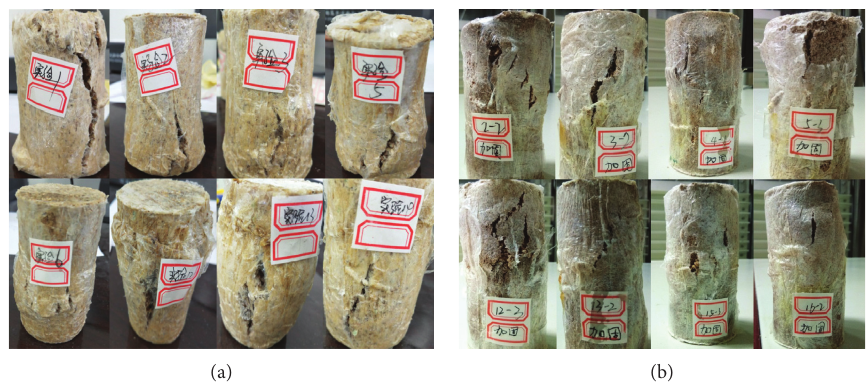
Figure 8: Splitting failure of specimens under uniaxial compression. (a) CCS and (b) CFS.